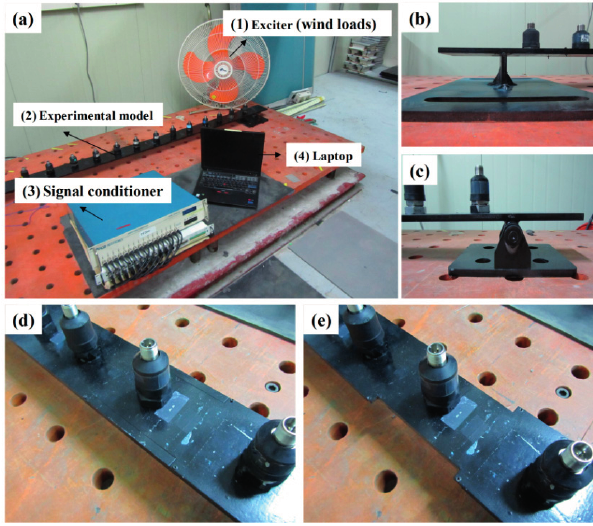
Figure 6. Experimental setup and damage scenarios: ( a ) experimental setup; ( b ) roller support; ( c ) pin support; ( d ) intact case; and ( e ) damage